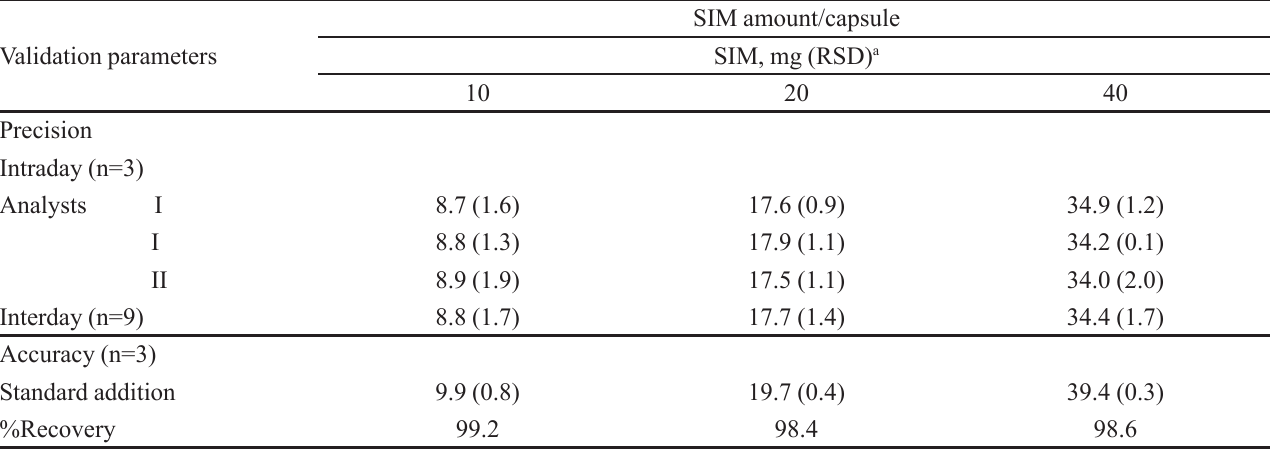
TABLE II - HPLC precision and accuracy results for SIM 20 mg compounded capsules provided by the university pharmacy (chromatographic conditions, Figure 2)